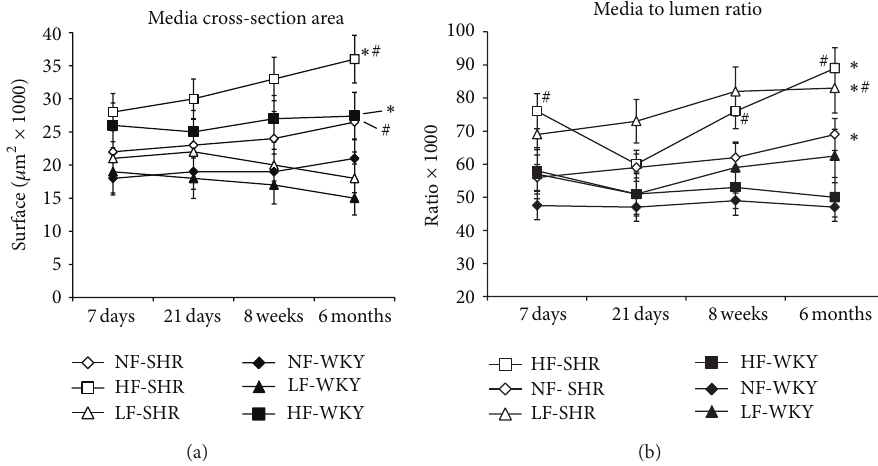
Figure 2: Media cross-section area (A) and media to lumen ratio calculated in mesenteric resistance arteries isolated from WKY rats and SHRs submitted to low flow (LF), high flow (HF), or normal flow (NF) for 1, 3, 8, or 24 weeks. Values represent mean ± SEM ( 𝑛 = 12 rats per group). ∗ 𝑃 < 0.01 , HF or LF versus NF arteries. # 𝑃 < 0.05 , SHRs versus WKY rats, within equivalent arteries (NF, LF, or HF).